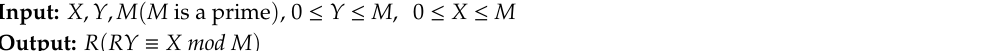
Algorithm 1 Equivalent Description of Modular division algorithm over prime field in